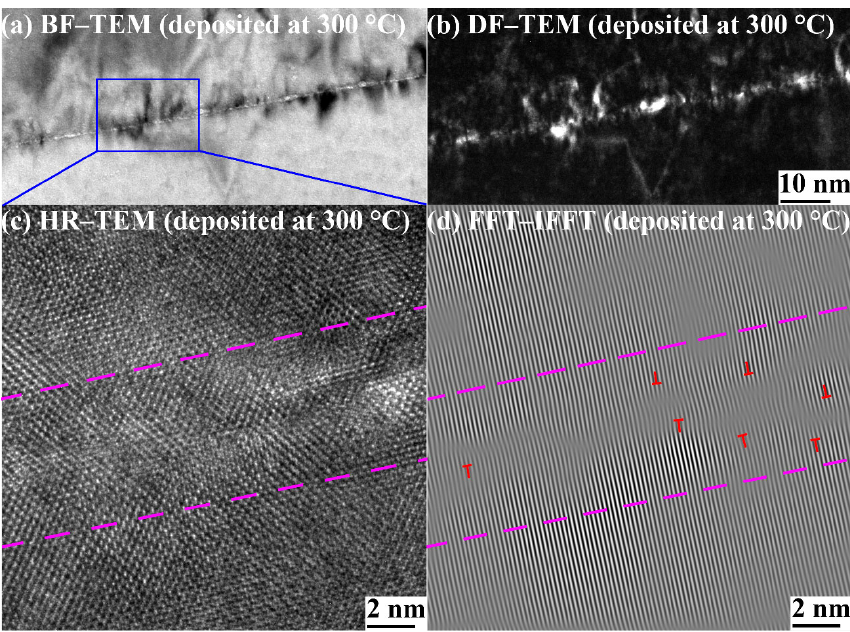
Fig. 21 Microstructure and quantitative characterization of the homoepitaxial YSZ–YSZ interface. (a) Bright-field (BF)-TEM, (b) dark field (DF)-TEM, (c) HR-TEM, and (d) fast Fourier transform (FFT)–inverse fast Fourier transform (IFFT) images of the film deposited at 300 ℃ . The interface region is marked by two pink dashed lines. The dislocations in (d) are marked by red signs. Reproduced with permission from Ref. [126], © ASM International 2017.